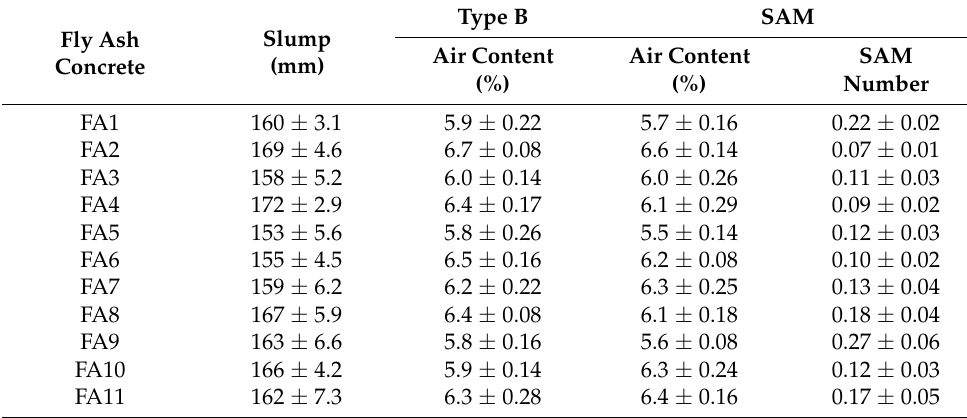
Table 5. Properties of fresh concrete right after mixing.